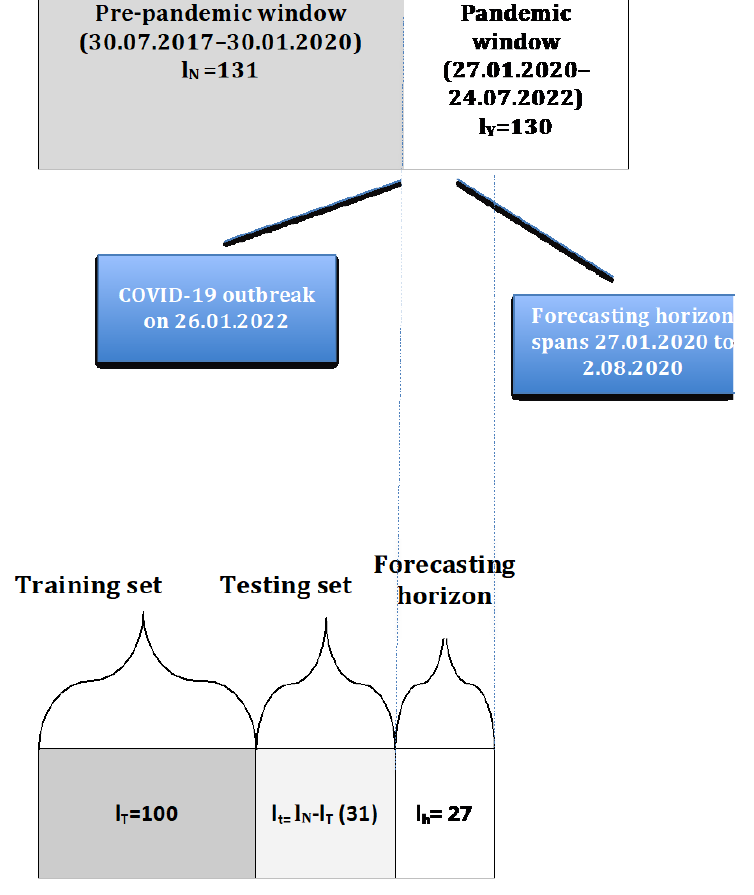
Figure 2. Data splitting